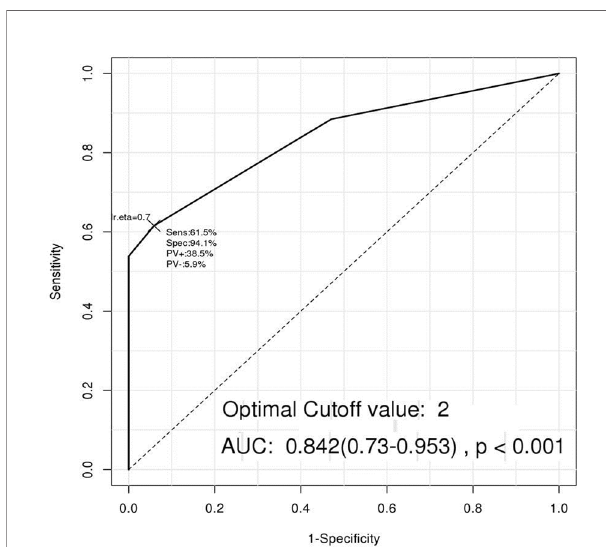
FIGURE 4 | The Receiver operating characteristic (ROC) curve of a new predicting model including the four volatile organic compounds (VOCs). When a VOC level was higher than its cut-off value, the VOC was de fi ned as positive, and a new ROC curve was constructed based on the positivity status of the four VOCs. This model showed the highest AUC of 0.842 with 61% sensitivity and 94% speci fi city when more than two VOCs were